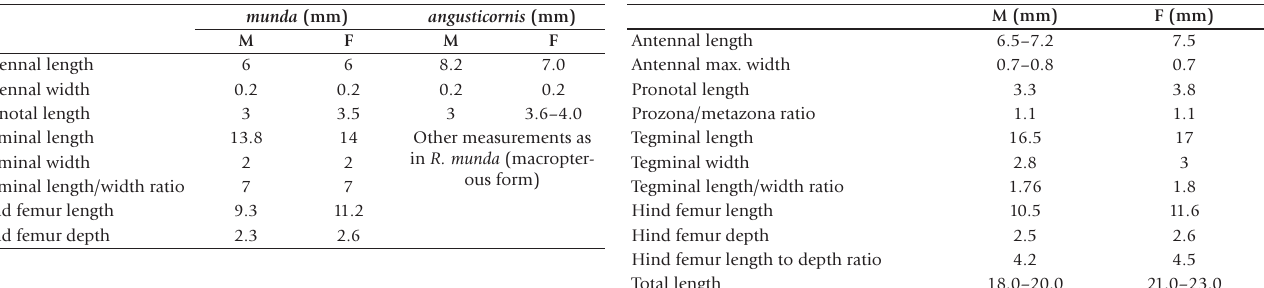
Table 5. Measurements of Rhabdoplea spp. Table 6. Morphometric measurements of Panzia uvarovi